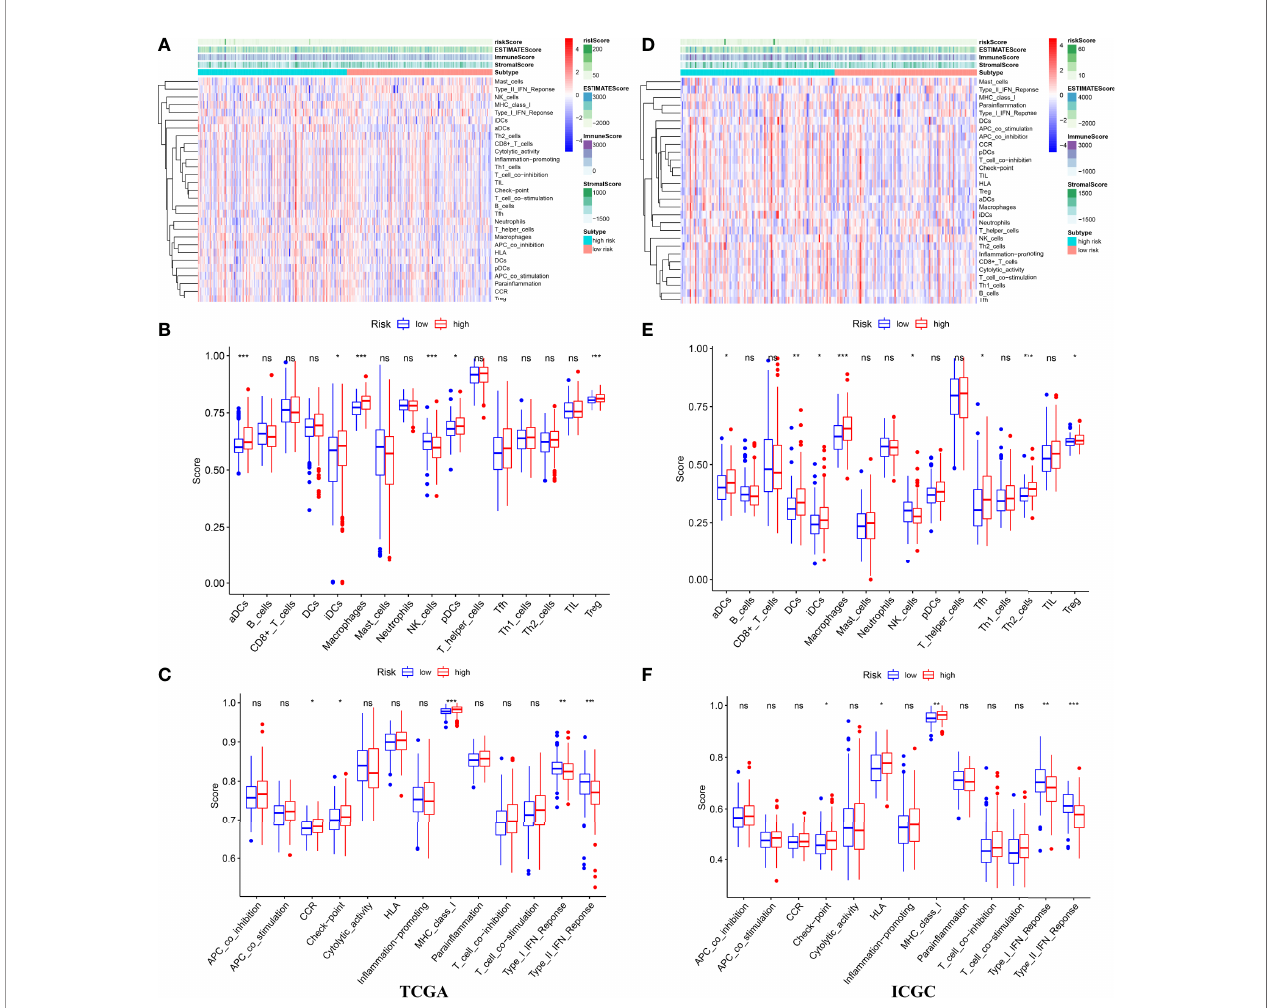
FIGURE 7 | The immune landscape between high- and low risk groups in the TCGA and ICGC cohort (A) The heatmap of immune cell in fi ltration and immune function in the TCGA cohort (B) The differences of immune cell in fi ltration between high- and low risk groups in the TCGA cohort (C) The differences of immune function between high- and low risk groups in the TCGA cohort (D) The heatmap of immune cell in fi ltration and immune function in the ICGC cohort (E) The differences of immune cell in fi ltration between high- and low risk groups in the ICGC cohort (F) The differences of immune function between high- and low risk groups in the ICGC cohort. ***p < 0.001; **p < 0.01; *p < 0.05. ns, no signi fi